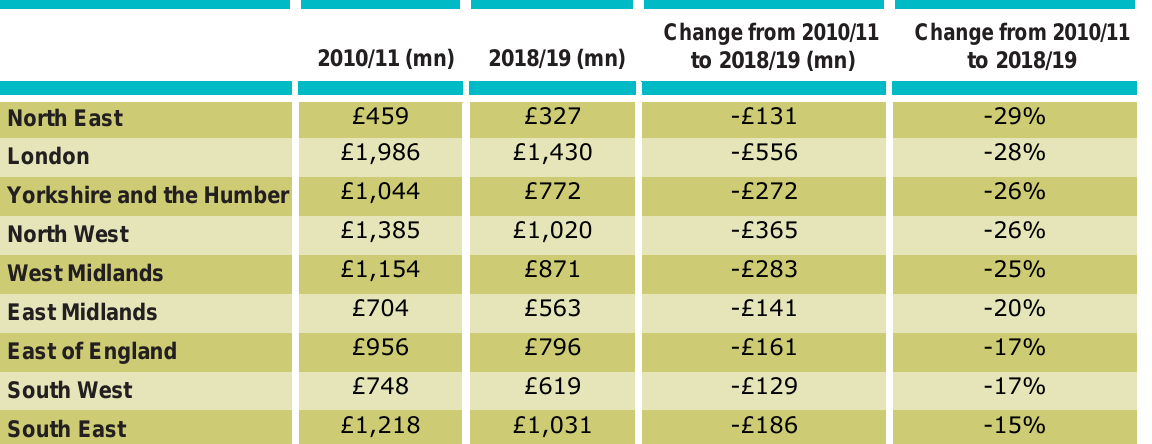
Table 1: Estimated funding for children and young people’s services by region in real terms 9